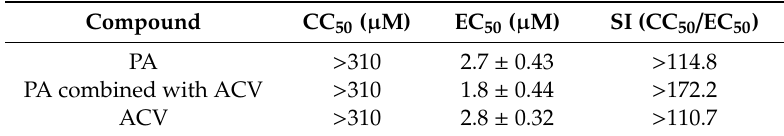
Table 2. Antiviral activity against the replication of herpes simplex virus type 2 (HSV-2) and cytotoxicity